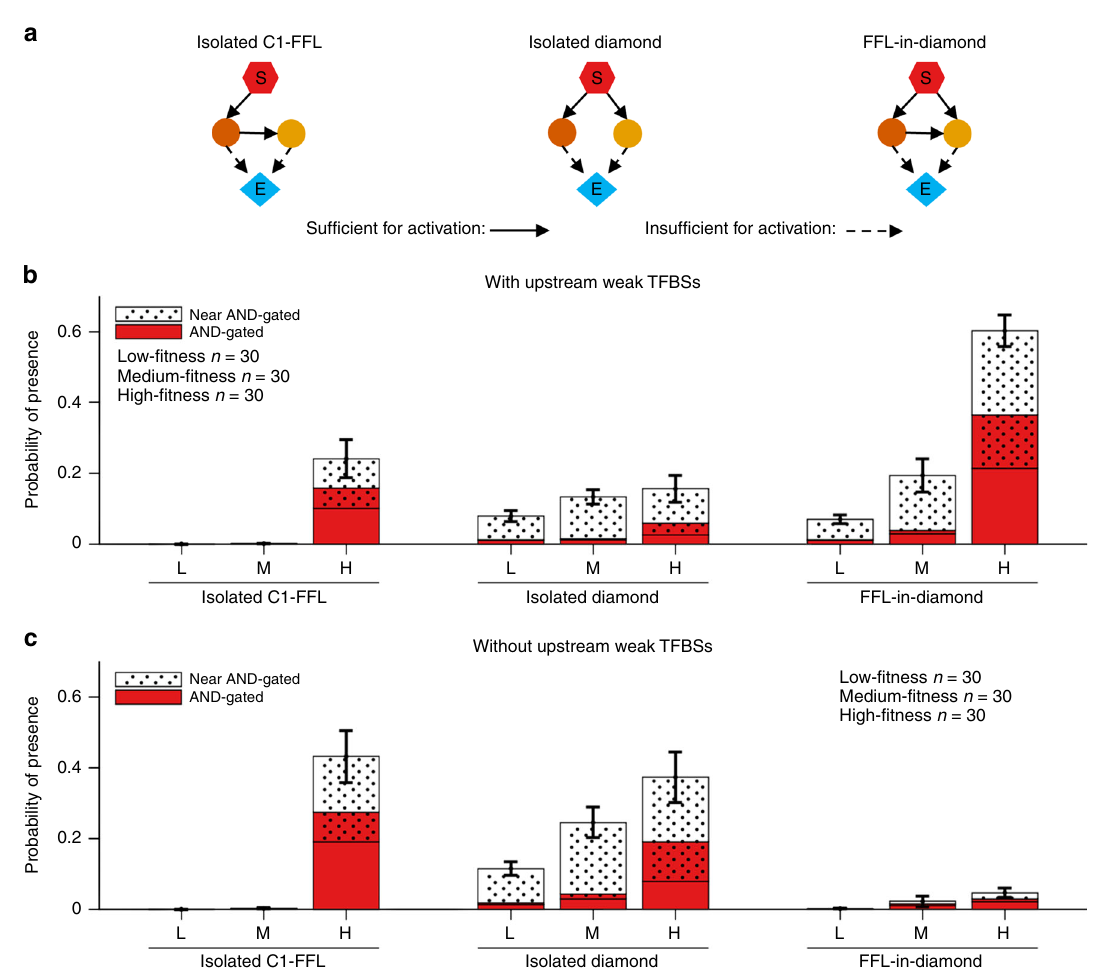
Fig. 7 AND-gated C1-FFLs and diamonds are associated with high fi tness in complex networks. Out of 238 simulations (Supplementary Fig. 6), we took the 30 with the highest fi tness (H), the 30 with the lowest fi tness (L), and 30 of around median fi tness (M). AND-gated motifs are scored while including weak TFBSs in the effectors ’ cis -regulatory regions, near-AND-gated motifs are those scored only when these weak TFBSs are excluded. a Diagrams of enriched motifs when weak TFBSs are included. It is possible for the same genotype to contain one of each, resulting in overlap between the red AND-gated columns and the dotted near-AND-gated columns. Weak TFBSs upstream in the TRN, i.e. not in the effector, are shown both included ( b ) and excluded ( c ). See Supplementary Methods for y -axis calculation details. Error bars show mean ± s.e.m. of the proportion of evolutionary steps containing the motif in question, across replicate evolutionary